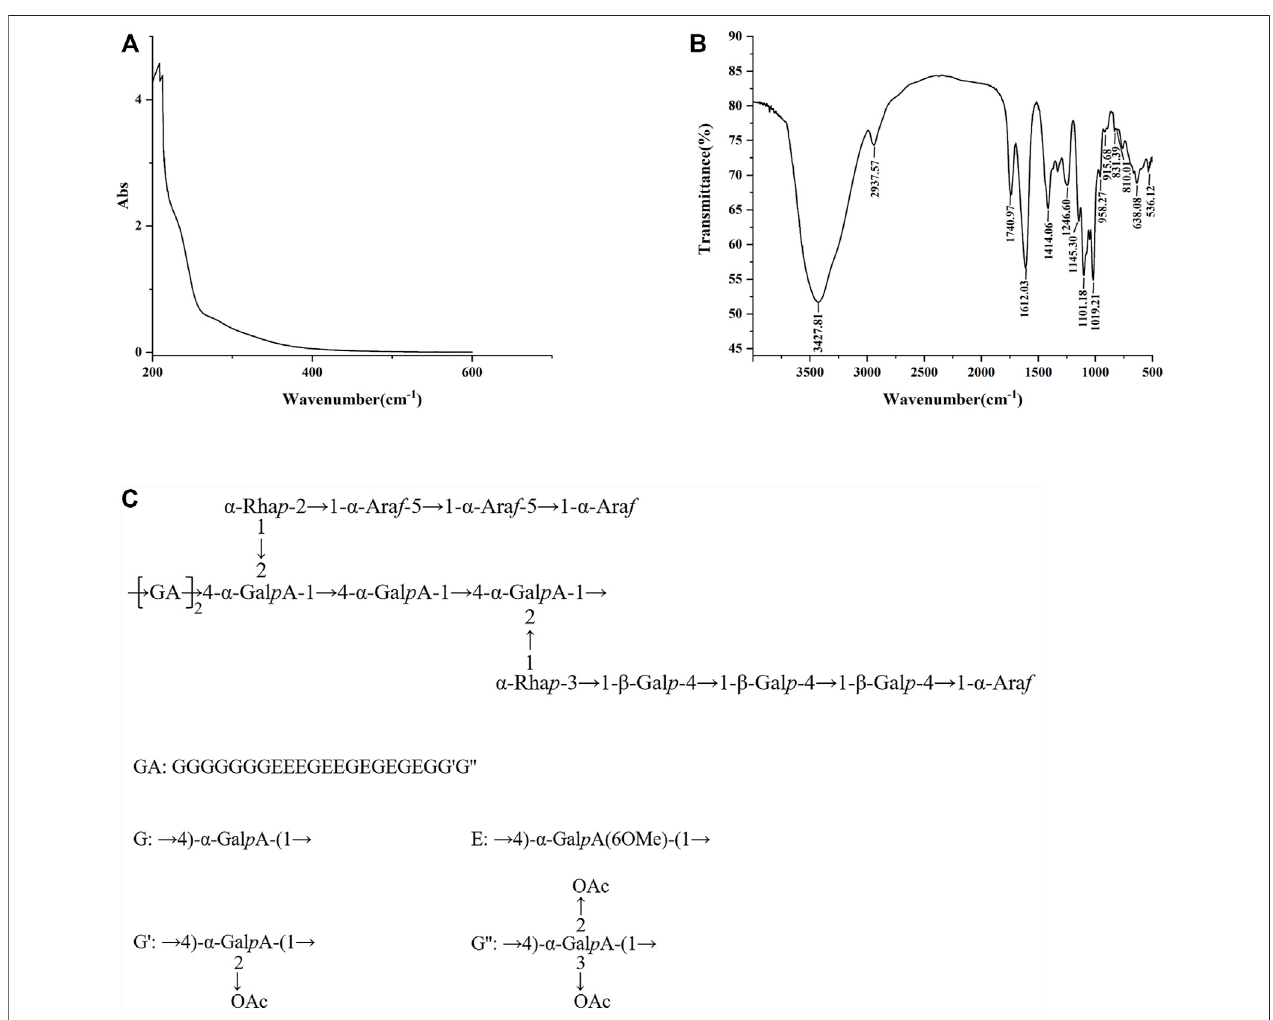
FIGURE 2 | The characterization of SCLP. The UV scanning (A) and the FT-IR spectra (B) of SCLP. (C) The repeating unit of SCLP.